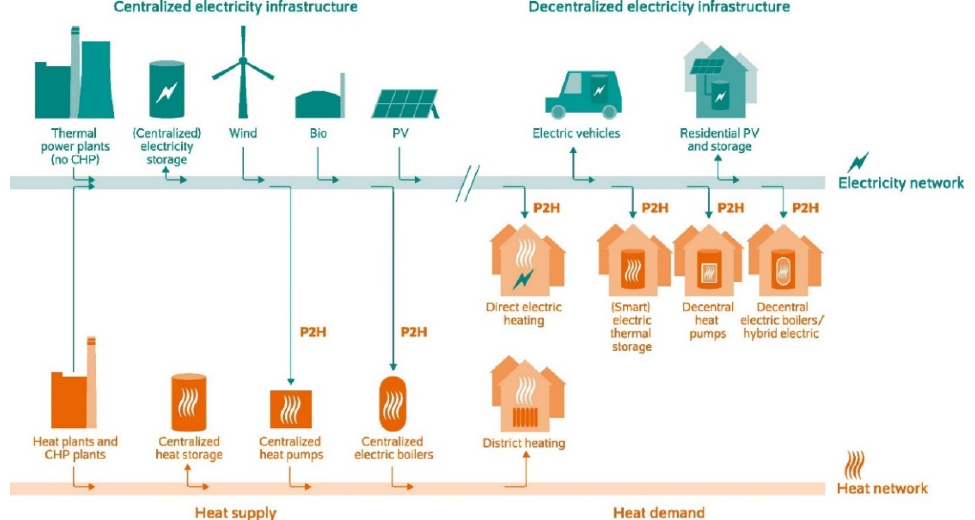
Figure 2. Linkage of power-to-heat options with DH networks and electricity